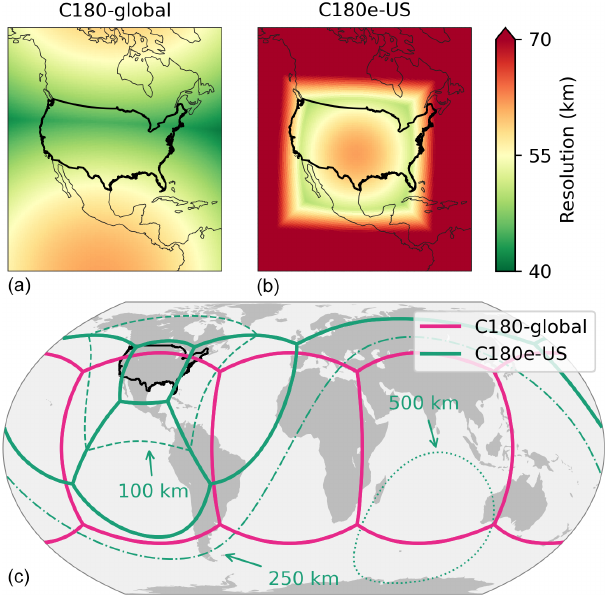
Figure 6. Comparison of C180-global and C180e-US grids. The top panels show the variability of resolution for both grids. The bottom panel shows the grid face edges for C180-global and C180e-US, with the 100, 250, and 500km resolution contours for